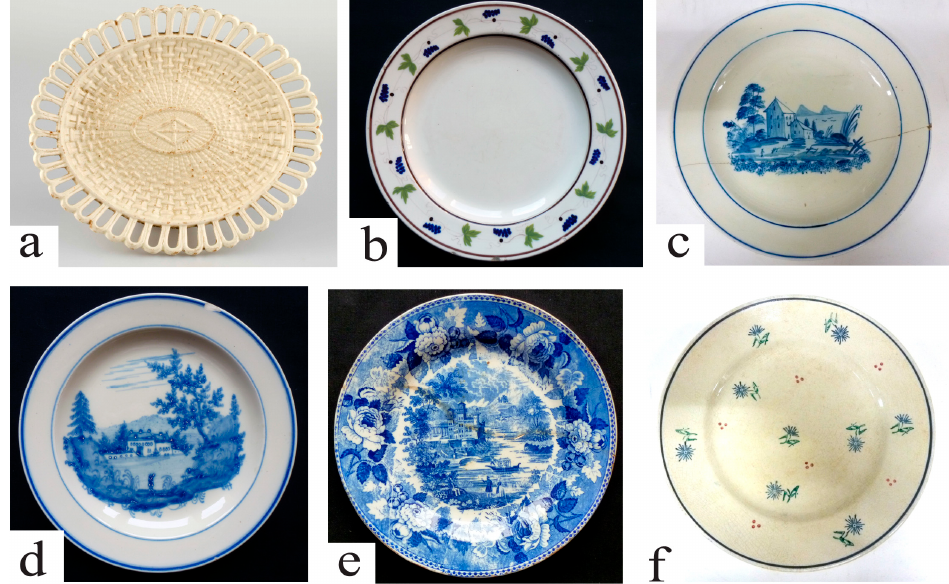
Figure 11. Map of Switzerland with the location of eight white earthenware manufactories: 1 Cornol (production start 1766), 2 Nyon (1790), 3 Lenzburg (1790), 4 Les Pâquis, Geneva (1791), 5 Kilchberg- Schooren, South of Zurich (1792), 6 Fribourg/Freiburg (1794), 7 Matzendorf (1798) and 8 Carouge (1803).